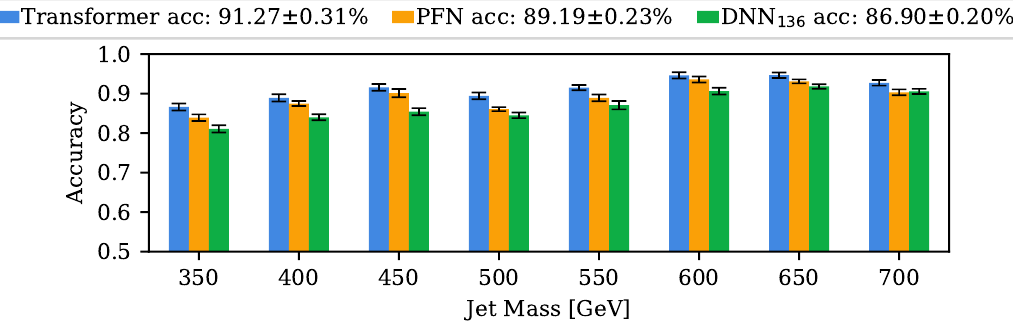
Figure 7 . Mean 10-fold accuracy and statistical uncertainty of the network prediction for jets within ranges of jet mass, for the three network studies. The jets are binned according to their mass in intervals of 50 GeV. The x-axis labels correspond to the upper bound of the